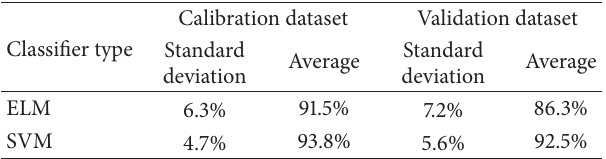
Table 4: Statistics results of overall classification accuracy of model using ELM and